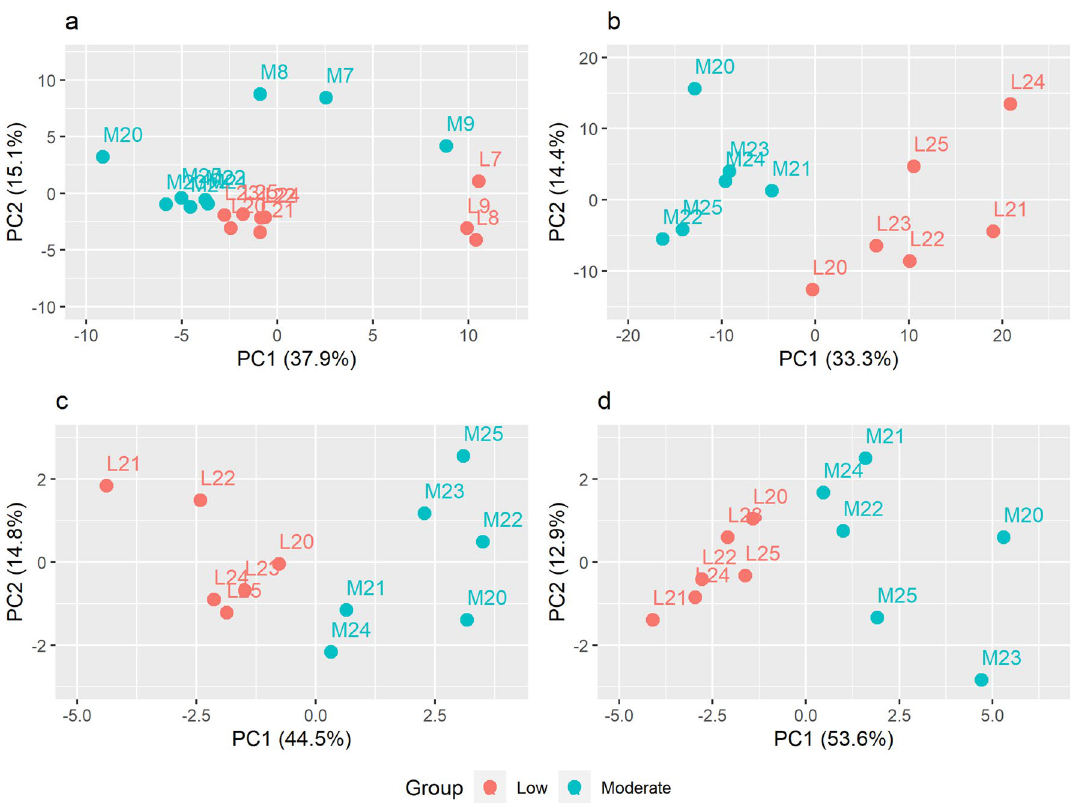
Figure 5. Principal component analysis. ( a ) PCA for the top 95 proteins arranged by ascending p-value from Analysis 1. ( b ) PCA for the top 515 proteins arranged by ascending p-value from Analysis 2. ( c,d ) Similar separation between humidity groups is observed by PCA for proteins corresponding to the aggregated functional clusters chaperone response and glutathione-related, respectively. M7–9 and M20–25 indicate the samples from control rabbits exposed to moderate humidity, and L7–9 and L20–25, samples from rabbits exposed to low